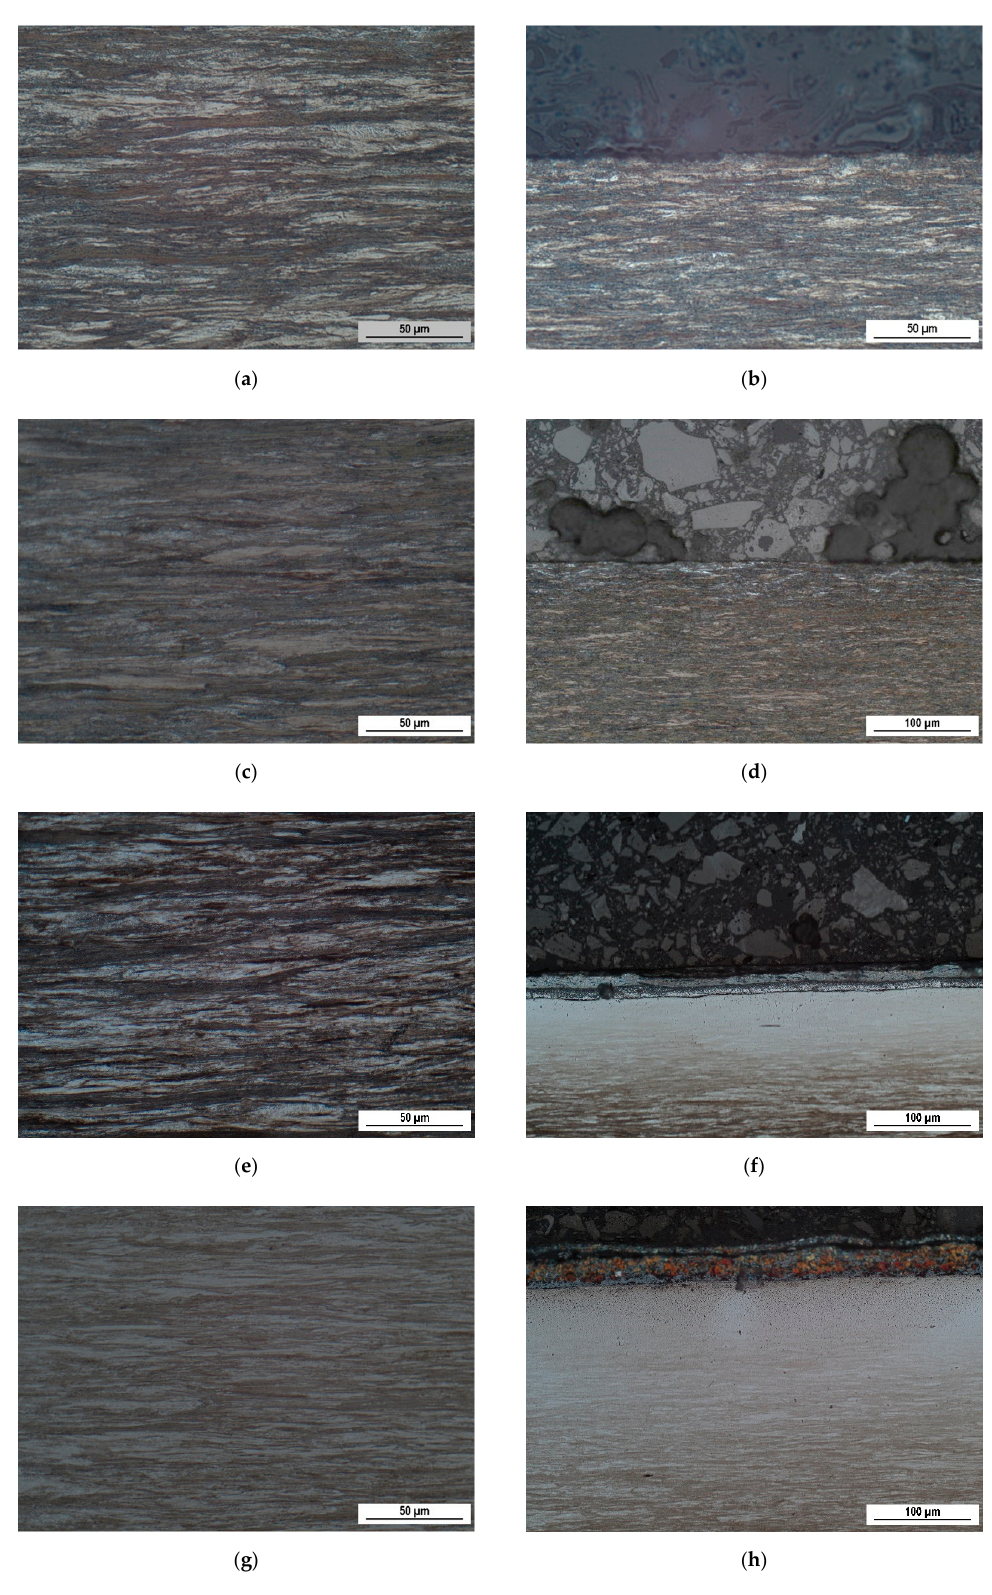
Figure 13. Metallographic images of wires surface—longitudinal direction: ( a ) conventional—bulk, ( b ) conventional—surface, ( c ) phosphated—bulk, ( d ) phosphated—surface, ( e ) galvanized—bulk, ( f ) galvanized—surface, ( g ) compacted—bulk, ( h )